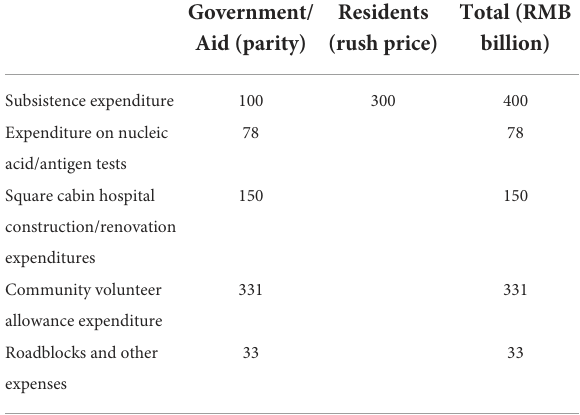
TABLE 4 Summary of the direct costs of shanghai seal